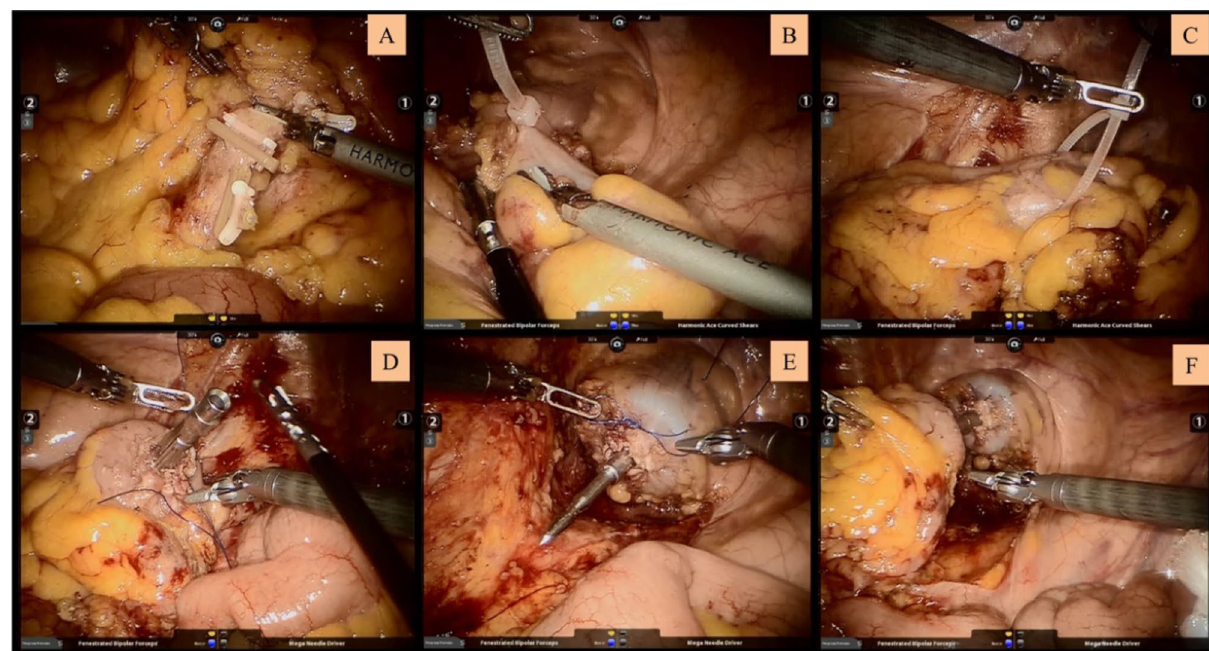
Figure 1. Surgical procedure. ( A ) The inferior mesenteric artery and vein were isolated and clipped by absorbable vascular clamps; ( B ) Rectum was ligated with self-locking nylon bandage; ( C ) Sigmoid colon was ligated with self-locking nylon bandage; ( D ) Suture the stump of sigmoid colon and put the orvil into the sigmoid colon; ( E ) Suture the stump of rectum; ( F ) Complete the